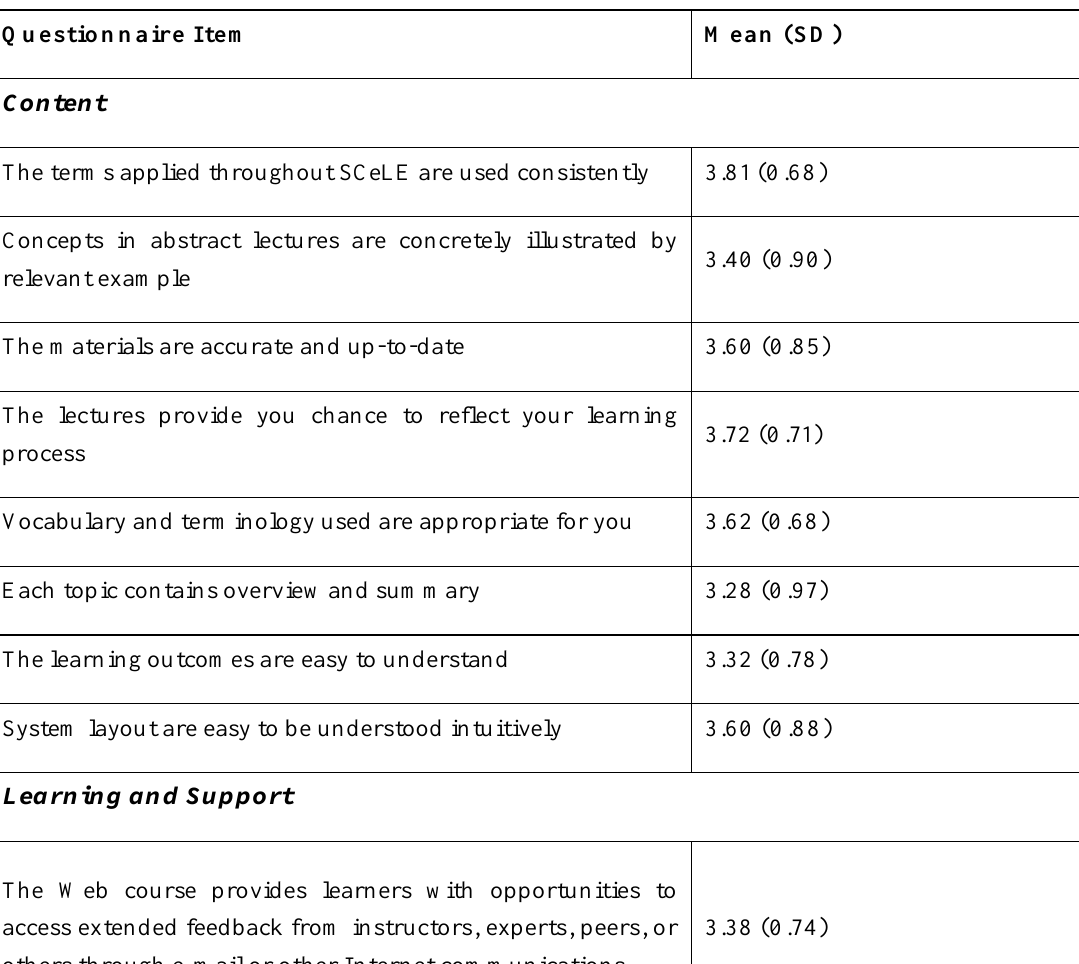
Mean and Standard Deviation of the Questionnaire Items (n =